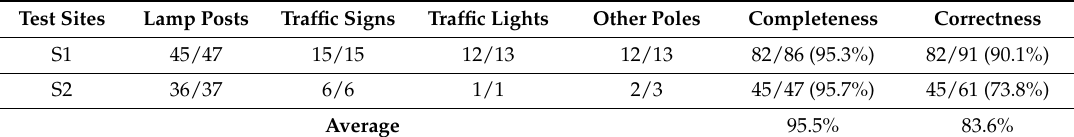
Figure 12. Pole extraction results of the two test sites. Table 3. Detection results in the test